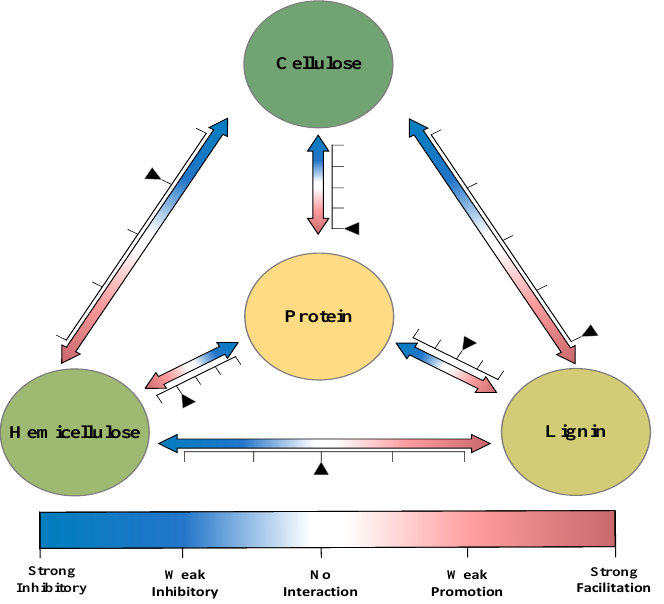
Figure 5. Model components interaction strength schematic during low-temperature hydro-thermal conversion.